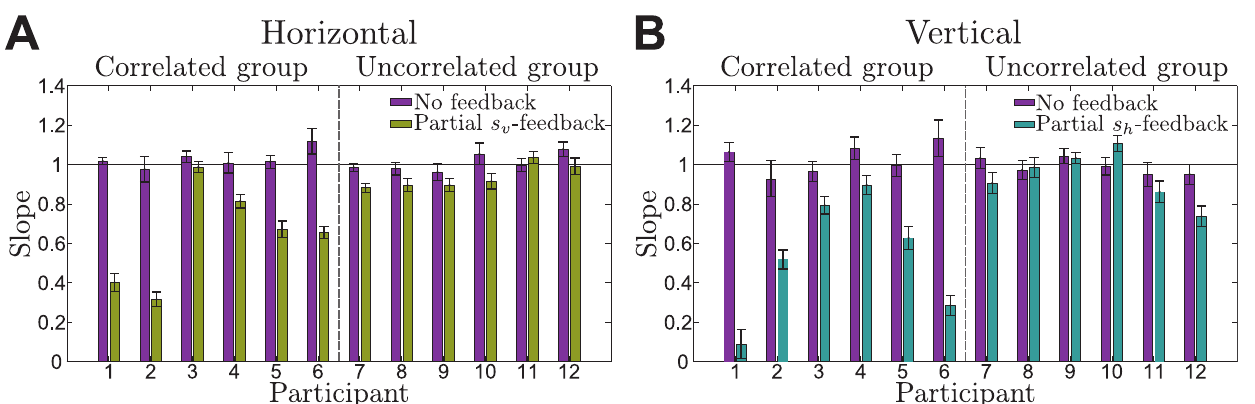
Fig 4. Performance of all participants in the last session of the experiment. The performance in the horizontal dimension is shown in panel A , performance in the vertical dimension in panel B . Performance is measured by slopes as in Fig 3 comparing no-feedback trials (purple) and partial feedback trials (yellow and cyan). Learning of the correlation structure is evident whenever the slope in the uninformative dimension of the partial feedback trials is significantly smaller than the slope in no-feedback trials (see also Fig 3). The perfect Bayesian response for no-feedback trials is characterized by a slope of one indicated by the thin black line, the Bayes-optimal slope for partial feedback trials would be zero — assuming that the Bayesian actor perfectly knows the statistics of the task. In both panels, error bars show standard errors of the robust